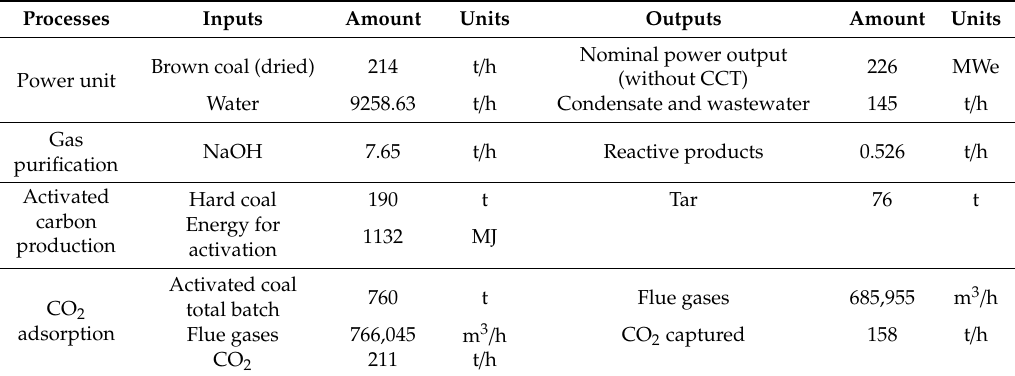
Table 4. Basic inventory data for scenario 2.